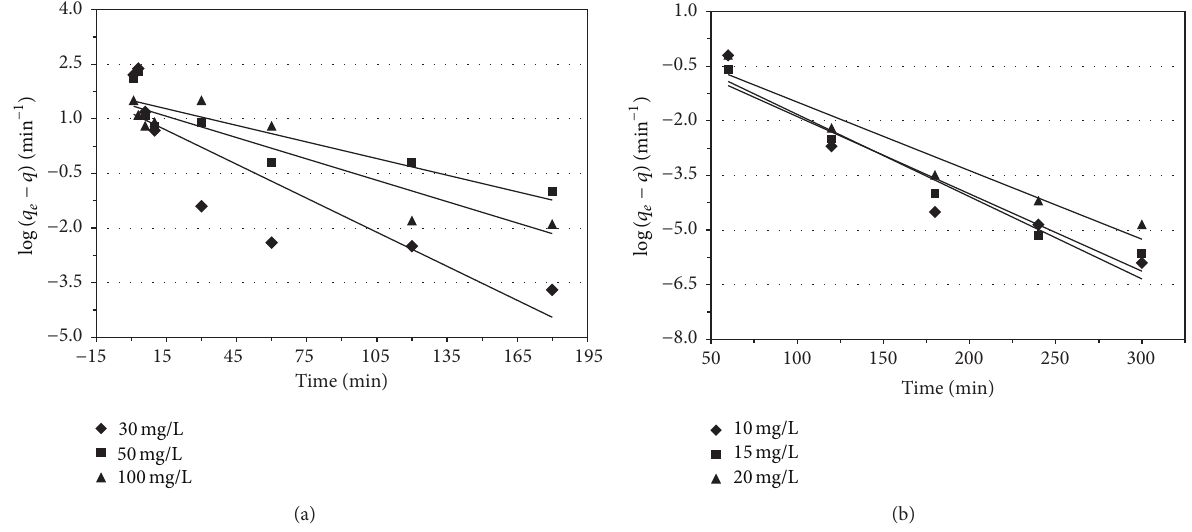
Figure 5: Pseudo-first-order models of LDPO-G for fluoride and phosphate removal. (a) Removal of phosphate at 30, 50, and 100mg/L. (b) Removal of fluoride at 10, 15, and 20 mg/L.